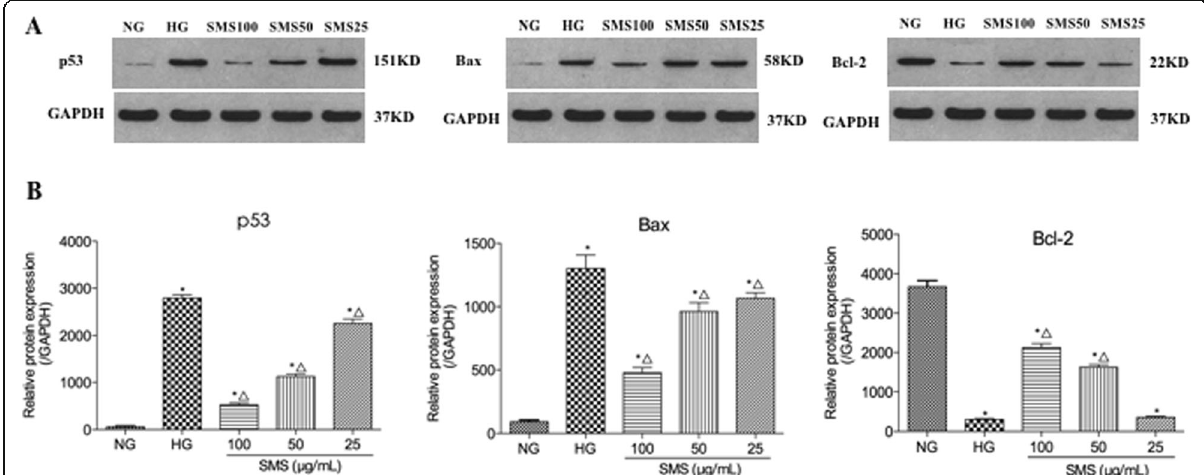
Fig. 5 Western blot and quantitative measurement for p53, Bax and Bcl-2 protein expressions in H9C2 cells. a Western blot. b Quantitative measurement. (* p < 0.05: vs. NG group; △ p < 0.05: vs. HG